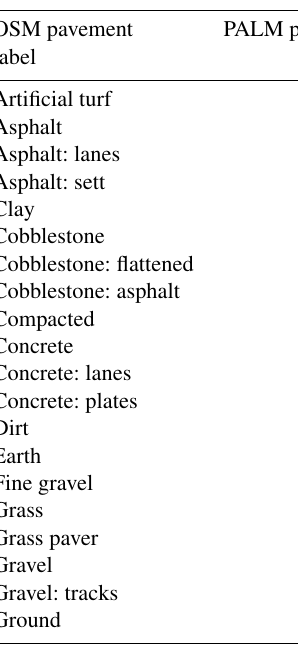
Table B4. OSM pavement labels and according PALM pavement